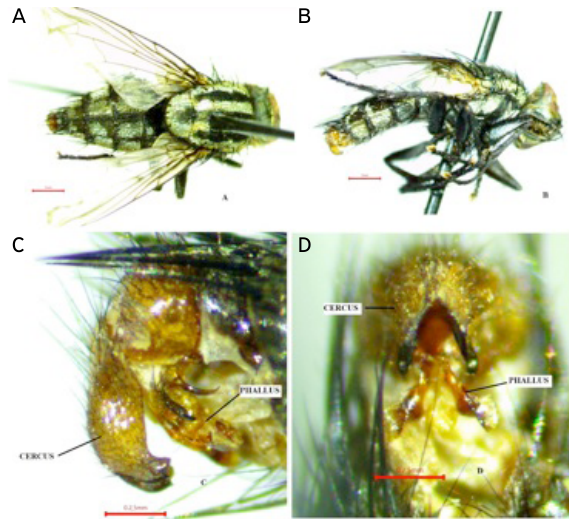
Figure 1. Peckia ( S. ) lambens (A) and (B), male habitus, dorsal and lateral views; (C) terminalia in lateral view; (D) teminalia in